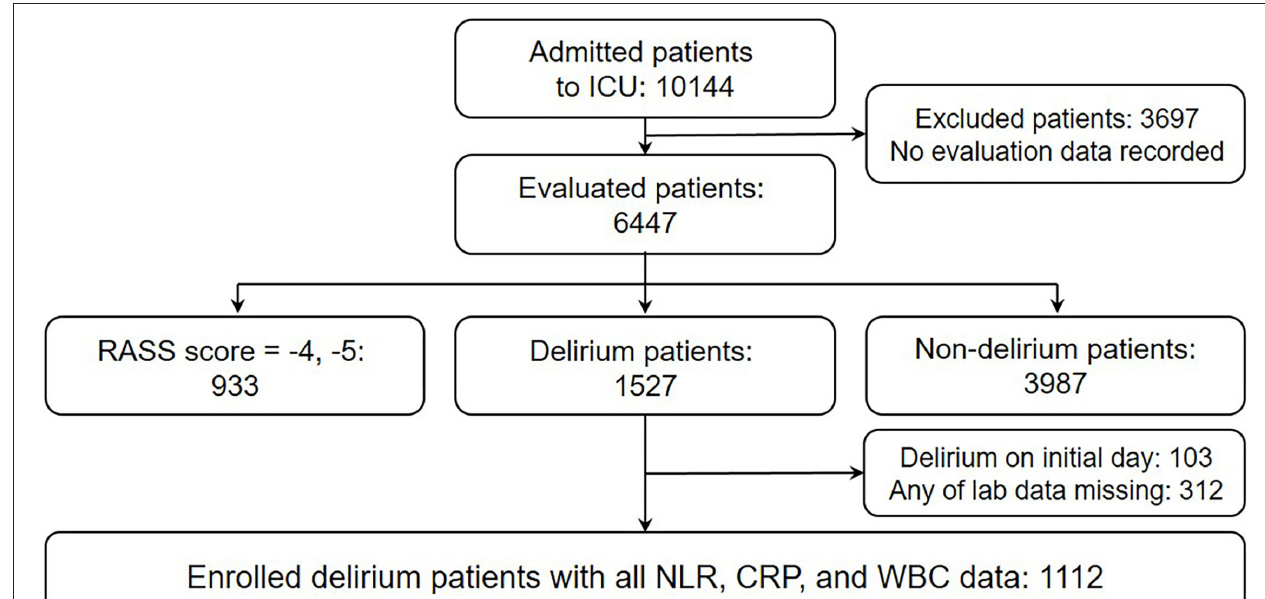
FIGURE 1 | Flowchart of inclusion criteria. ICU, intensive care unit; RASS, Richmond Agitation-Sedation Scale; NLR, neutrophil-lymphocyte ratio; CRP, C-reactive protein; WBC, white blood